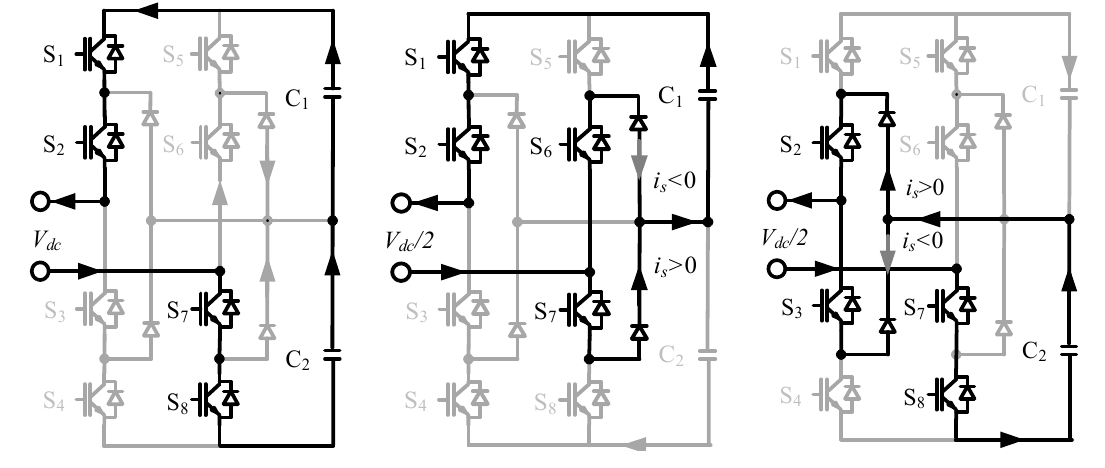
Figure 2. Mode 1, Mode 2 and Mode 3 of 3LNPC-CC (u ab = V dc , u ab = 0.5 V dc ).